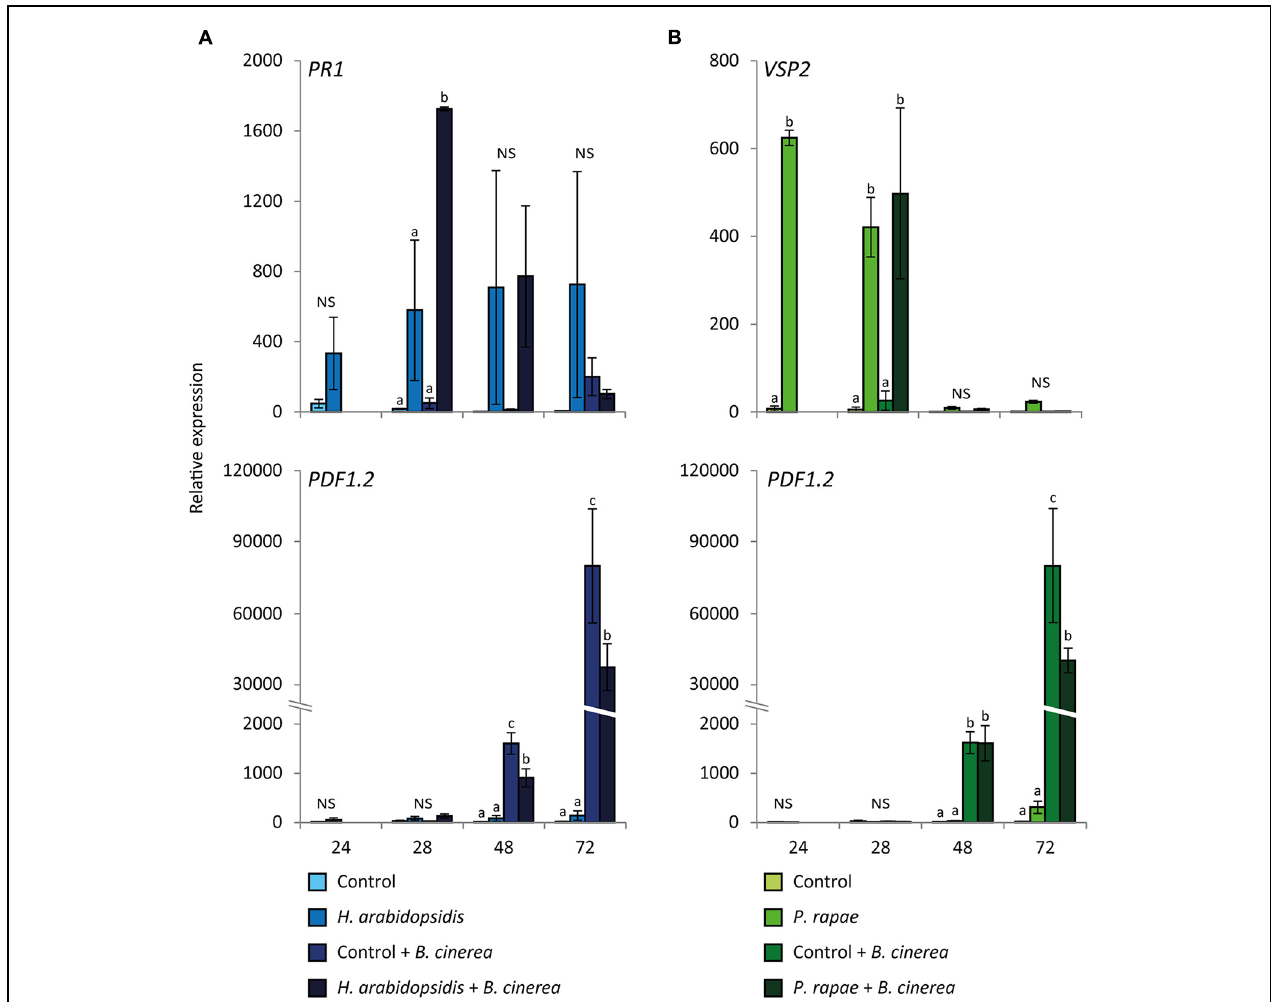
FIGURE 1 | Differential expression of PR1 , VSP2, and PDF1.2 in response to multiple attackers. RT-qPCR analysis of Hyaloperonospora arabidopsidis -responsive PR1 expression (A) , Pieris rapae -responsive VSP2 expression (B) and Botrytis cinerea -responsive PDF1.2 expression (A,B) . Plants were either inoculated with H. arabidopsidis or infested with P. rapae caterpillars.